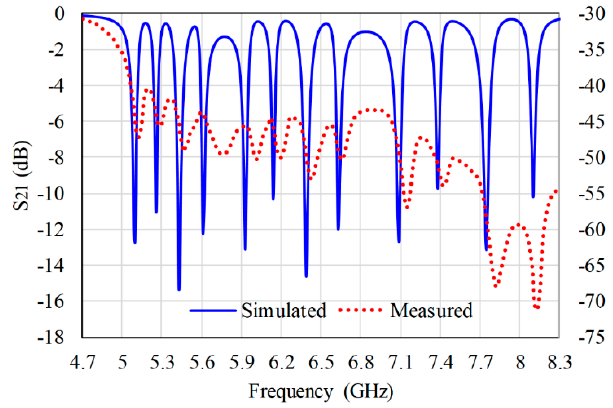
Figure 18. Measured and simulated S 21 of code 111111111111.